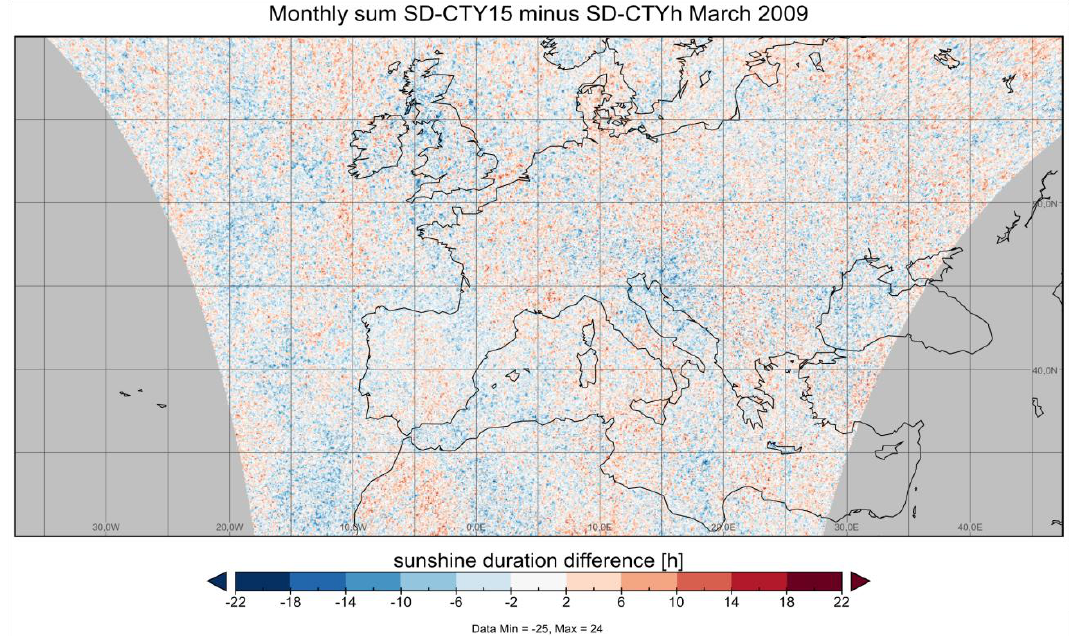
Figure 1. Differences between the SD-CTY calculated from 15-minute input data and SD-CTY from 1-hourly data for March 2009 (SD-CTY15 minus SD-CTY60).